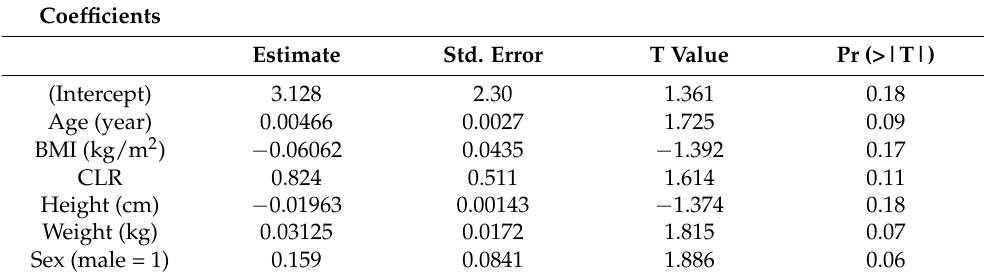
Table 6. Logistic regression of the algorithm obtained from the Hungarian patients on the radius.